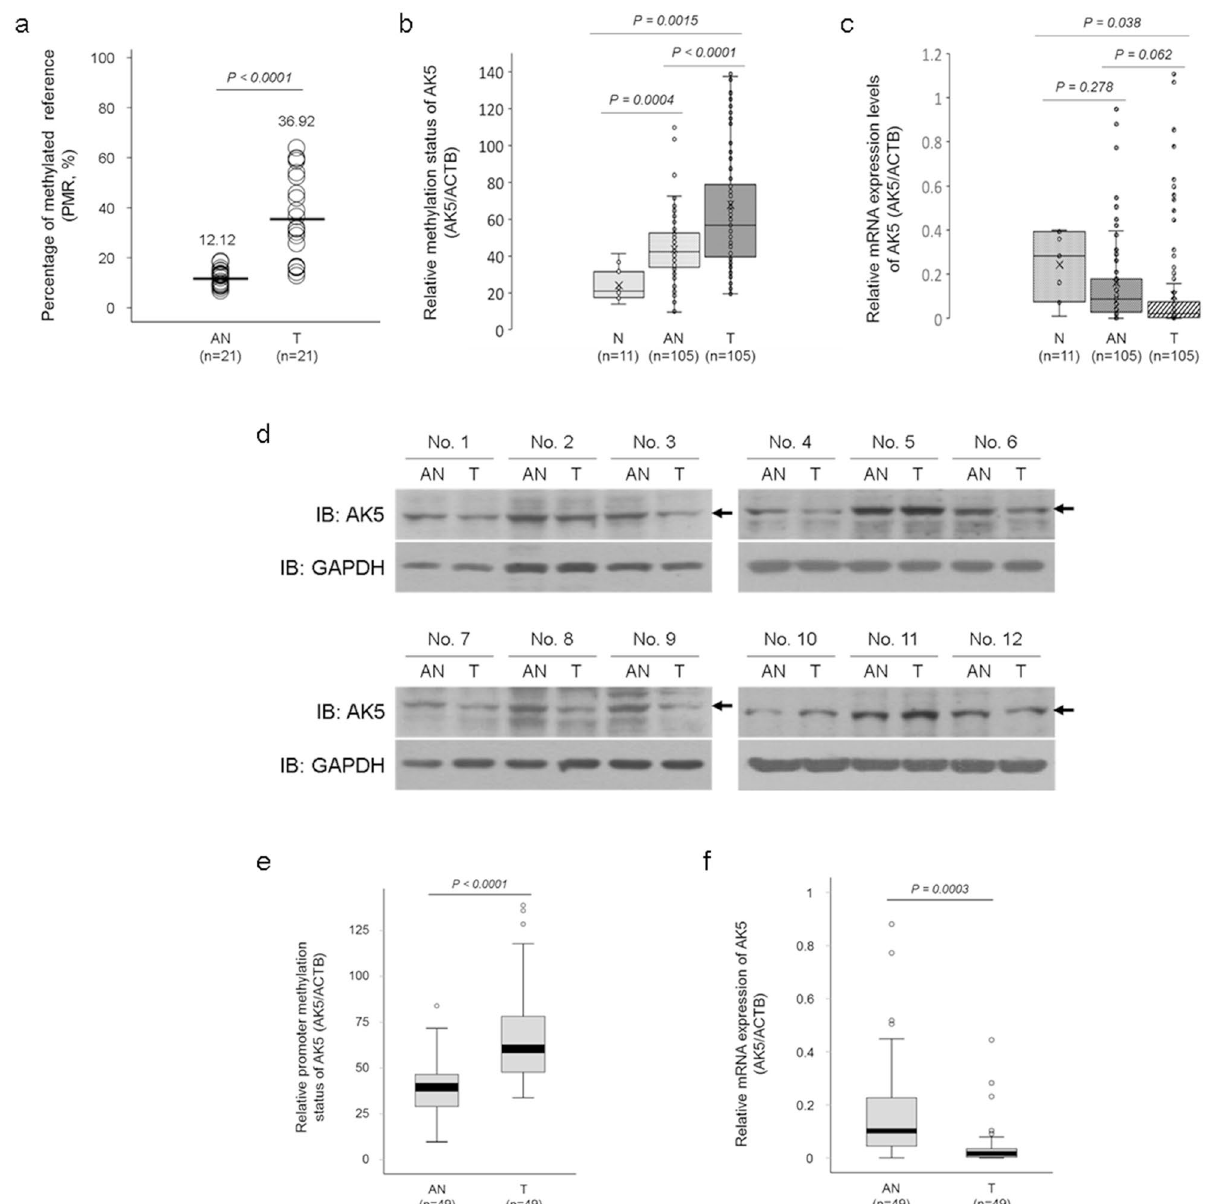
Figure 1. AK5 methylation status and expression levels in CRC tissues and adjacent normal tissues. The AK5 methylation status in 105 paired CRC and adjacent normal tissues and eleven normal tissues was assessed using methylation bead chip array and qMSP. ( a ) The chip array results showed that AK5 is hypermethylated in 21 CRC tissues compared to adjacent normal tissues. ( b ) The AK5 gene is dramatically and significantly hypermethylated in 105 adjacent normal tissues and 105 CRC tissues compared to normal tissues. ( c ) AK5 mRNA expression decreased in the adjacent normal tissues compared to the normal tissues and decreased in the CRC tissues compared to the adjacent normal tissues, but the effect was not statistically significant. ( d ) AK5 protein expression decreased in CRC tissues compared to adjacent normal tissues. ( e ) AK5 hypermethylation was significant in CRC tissues compared to paired adjacent normal tissues in 49 CRC tissues with a cut off value of 40%. ( f ) In 49 CRCs, AK5 mRNA expression significantly decreased in CRC compared to 49 paired adjacent normal tissues. Full-length bolts images or original gel images of AK5 protein expression are presented in Figure S5a. * P-values of < 0.05 were considered statistically significant. PMR percentage of methylated reference, AN adjacent normal tissue, T colorectal cancer tissue, N normal colon tissue, IB